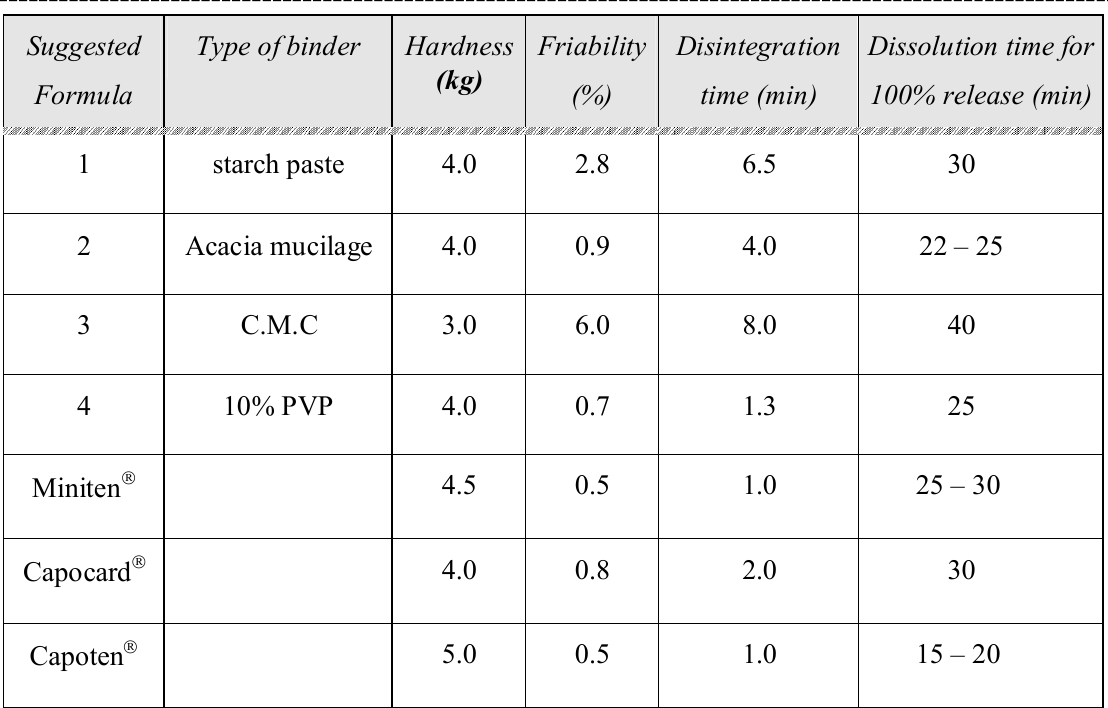
Table (2): Effect of binder type on the hardness, friability, disintegration time and dissolution